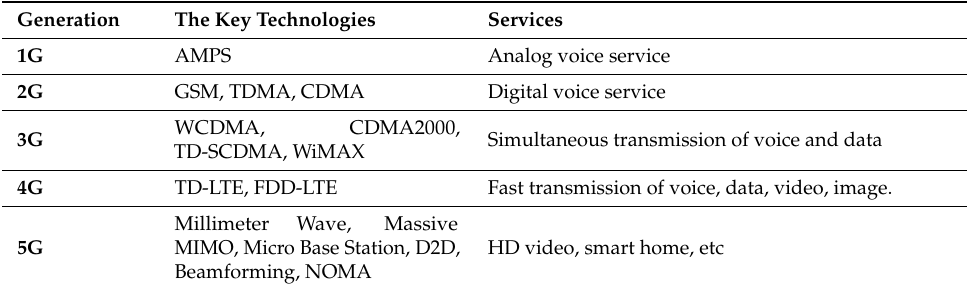
Table 1. The evolution of telecommunication